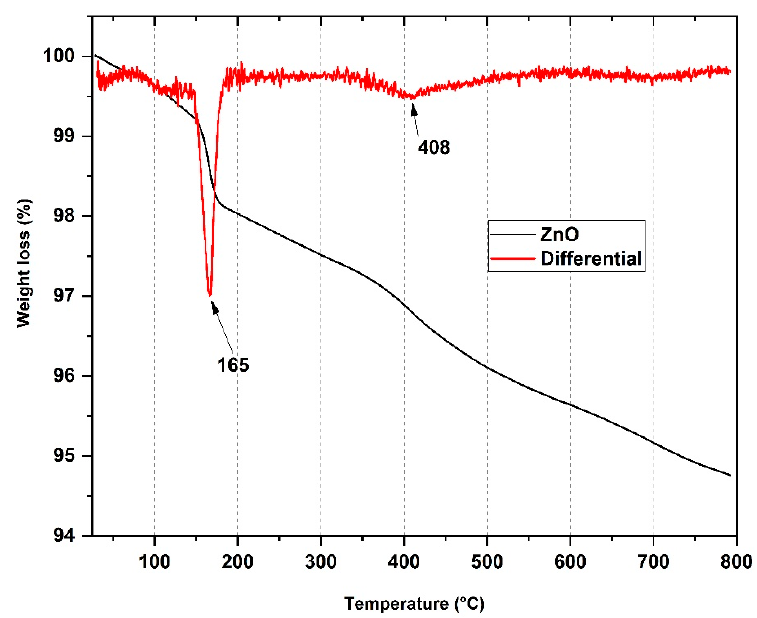
Figure 3. Thermogravimetric analysis of the ZnO-NPs.